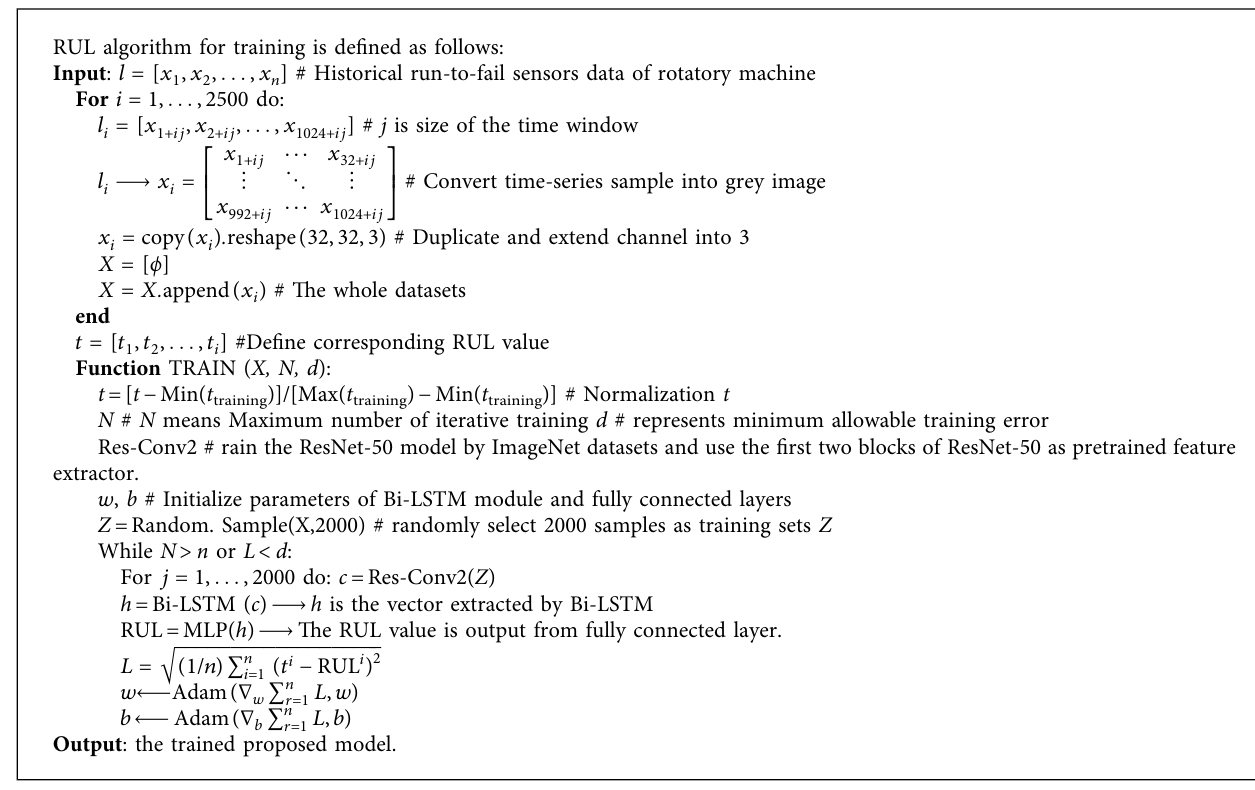
A LGORITHM 1: The RUL algorithm for